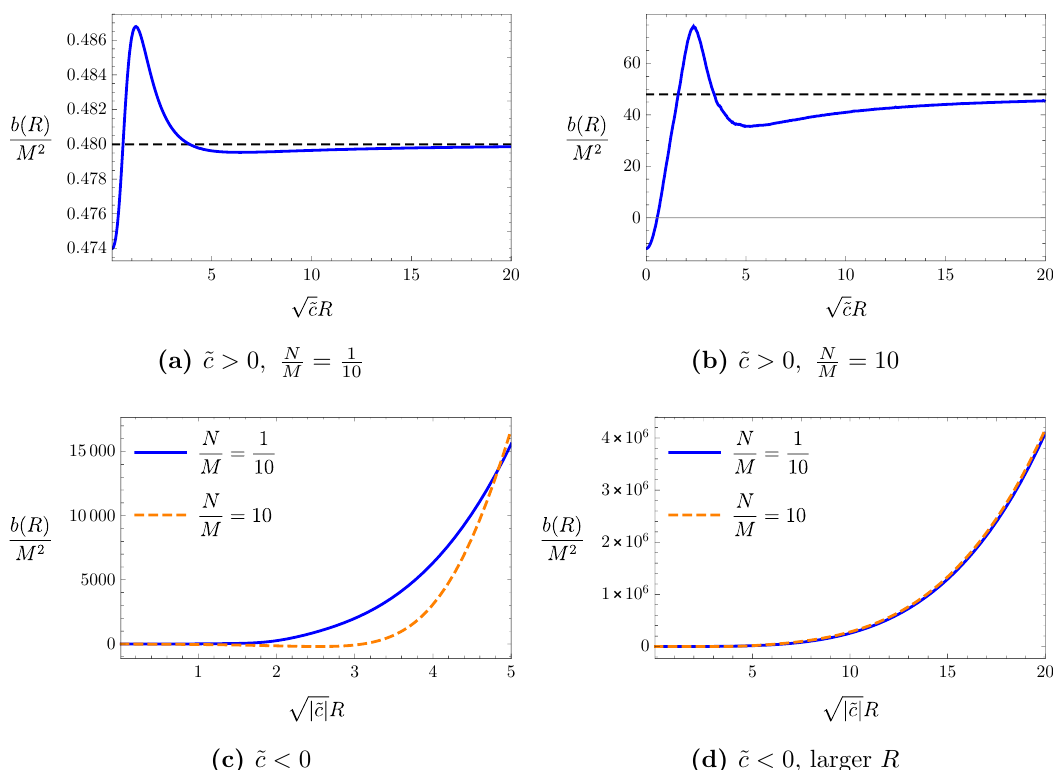
Figure 7. The b -function for solutions wrapping S 3 (cid:26) AdS 7 . For both signs of ~ c , b ( R ) tends to p the UV central charge (5.20) as j ~ c j R ! 0. For ~ c > 0, dual to a defect RG (cid:13)ow, as the b -function tends toward the IR value (5.25), as indicated by the horizontal dashed line. The b - function interpolates non-monotonically between these two limits. For ~ c < 0 the b -function appears to increase without